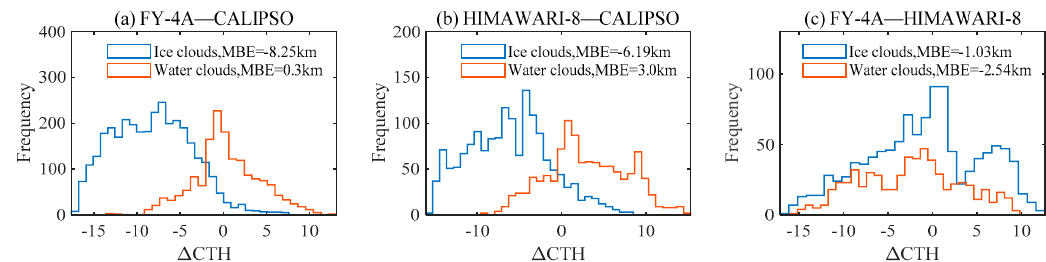
Figure 2. The ∆ CTH frequency distribution of ice clouds and water clouds between different satellites. ( a ) FY-4A–CALIPSO ( b ) HIMAWARI-8–CALIPSO ( c ) FY-4A–HIMAWARI-8.